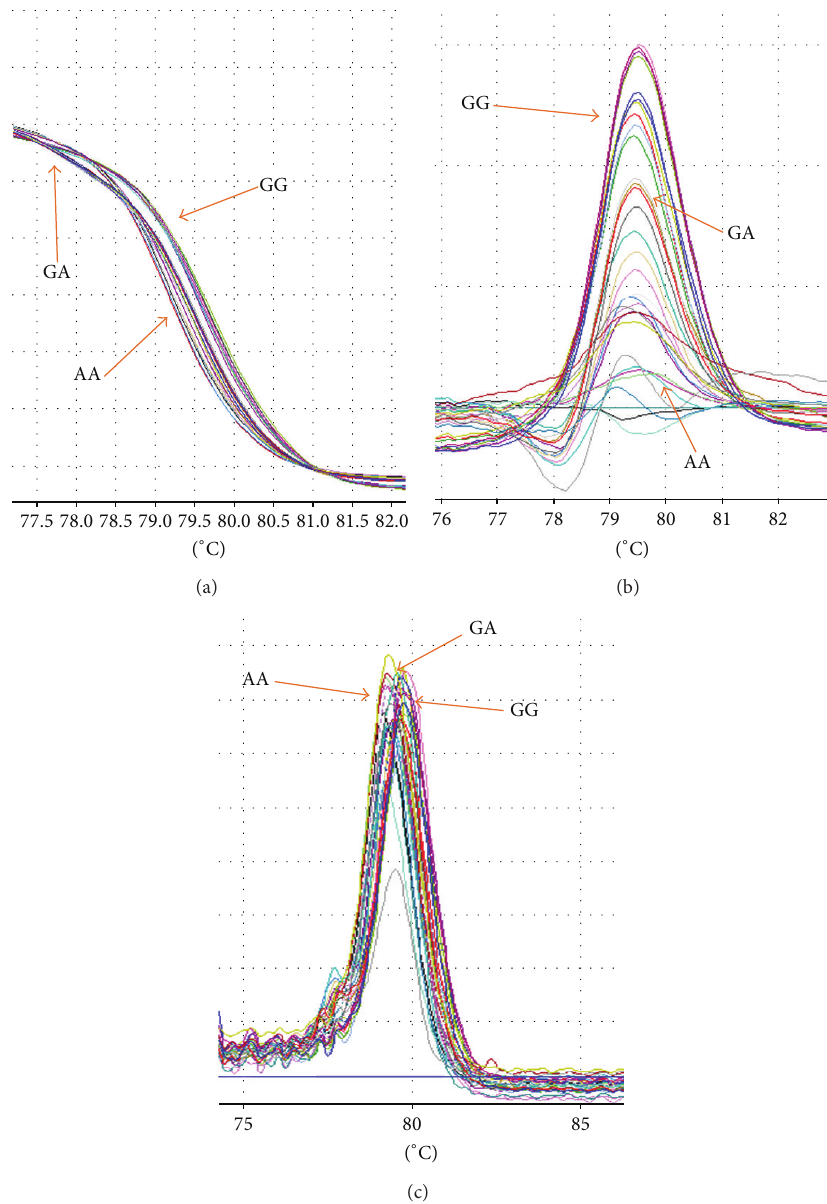
Figure 1: The difference graph of HRM analysis for the genotypes of R219K polymorphism. (a) demonstrated the normalized graph, (b) revealed the difference graph, and (c) was melting graph. In these graphs WT had higher Tm and HOM had lower